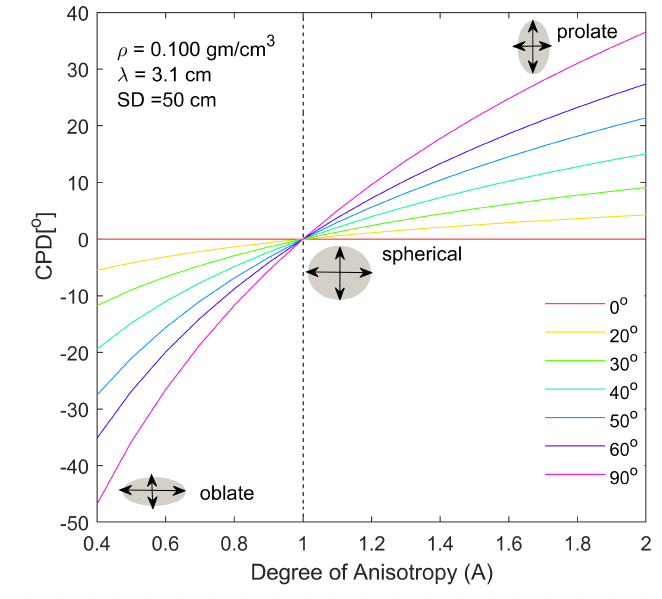
Figure 3. The simulated co-polar phase difference ( φ c ) as a function of degree of anisotropy ( A ), snow depth (SD), ρ s , λ , and incidence